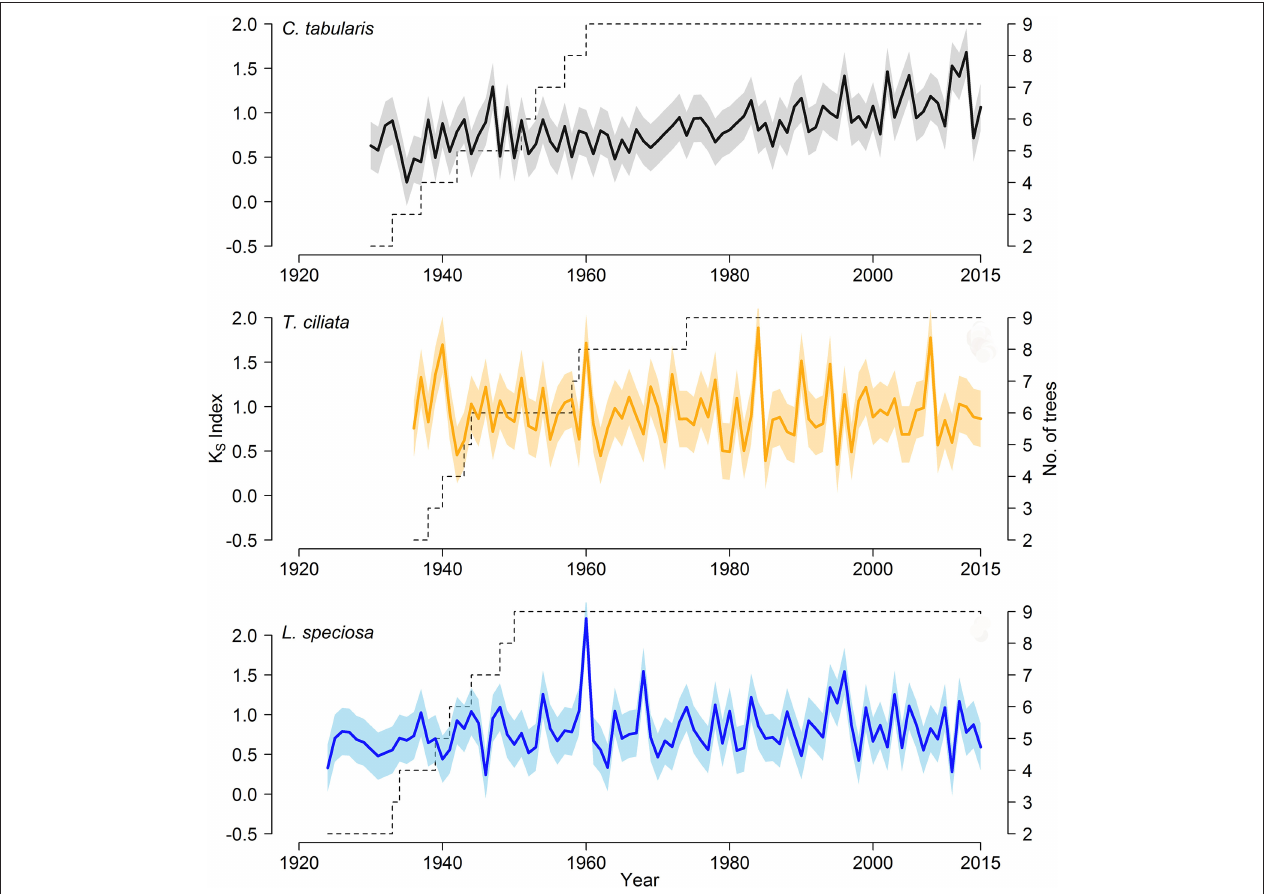
FIGURE 5 | Standard chronologies of hydraulic conductivity (K S ) of three South Asian tropical moist forest tree species; Color shading shows a ± 1 SD interval around the means of the